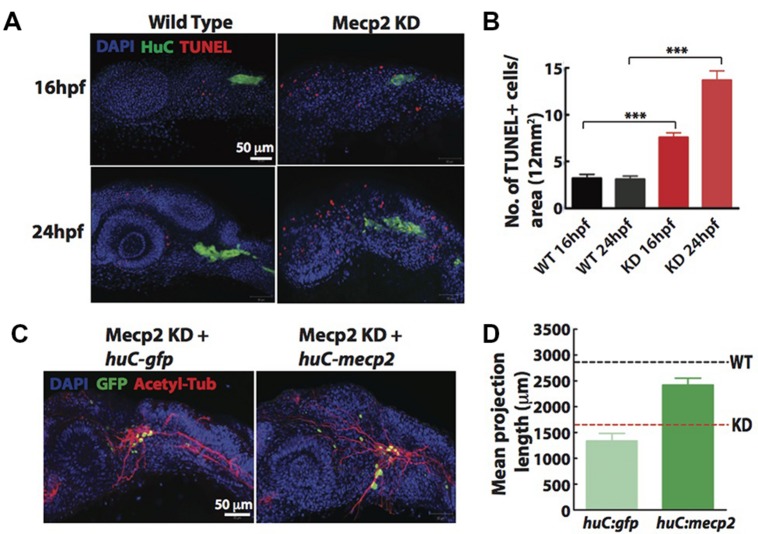
Cell autonomous effect of Mecp2 on sensory neurons during embryonic development. Embryos were injected with mecp2 MO and labeled with TUNEL. Antibody against HuC was used to label cell bodies in TG. Representative images showing TUNEL labeling in TG in wild-type controls (WT, left panel), Mecp2 morphants (right panel) (Blue – DAPI, Green – HuC and Red – TUNEL) (A). Quantitative analysis of TUNEL-labeled cells (indicative of apoptosis) at 16 and 24 hpf were presented in graphs showing total number of TUNEL positive cells per 12 mm × 12 mm in the head (B). Representative images showing peripheral axonal projections from sensory neurons of TG in Mecp2 morphants rescued by coinjection with huC-gfp control plasmids (left panel) or huC-mecp2 plasmids (right panel) (C). Quantitative analysis of total peripheral projections of trigeminal sensory neurons, with graphs presenting total length of peripheral projections from trigeminal ganglia per zebrafish (D). N > 10 in each group. Scale bar = 50 μm (∗∗∗P < 0.0001, one-way ANOVA with Bonferroni’s post hoc test).